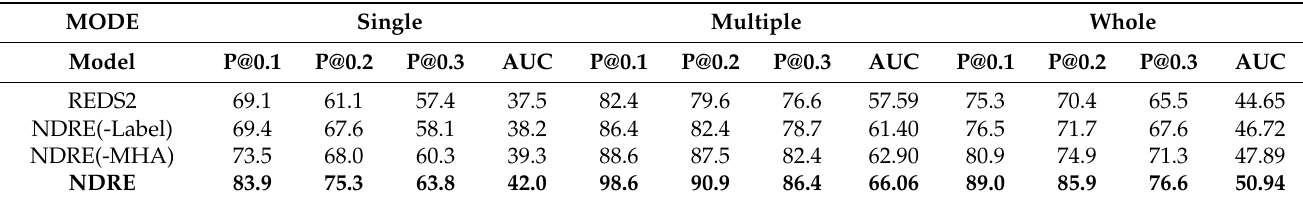
Table 2. Results of precision at recall (P@) and the area under the curves (AUC) under different testing modes. MODE Single